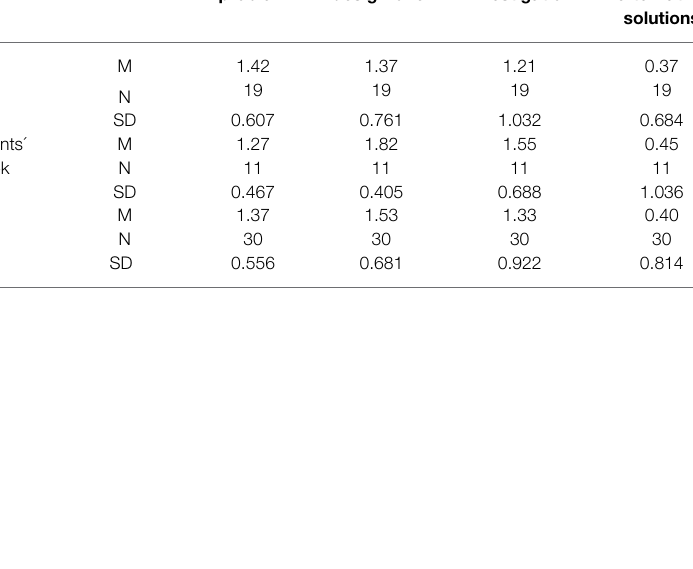
TABLE 5 | Means and standard deviations on the extent of the inclusion of the 9 EDP in all types of activities. Activity